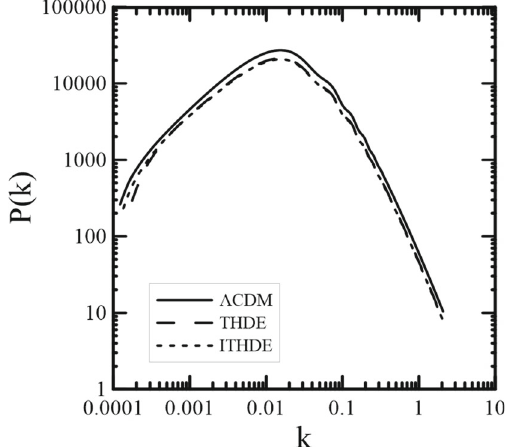
Fig. 5 The evolution of v 2 s versus redshift for the THDE model with consideration of the Hubble horizon as IR cutof. Dashed line indicates theinteractingandsolidlineindicatesthenon-interactingmodelaccord- ing to the best fitted value of parameters listed in the Table 1. The nega- tive value of trajectory shows the instability against perturbation of the background